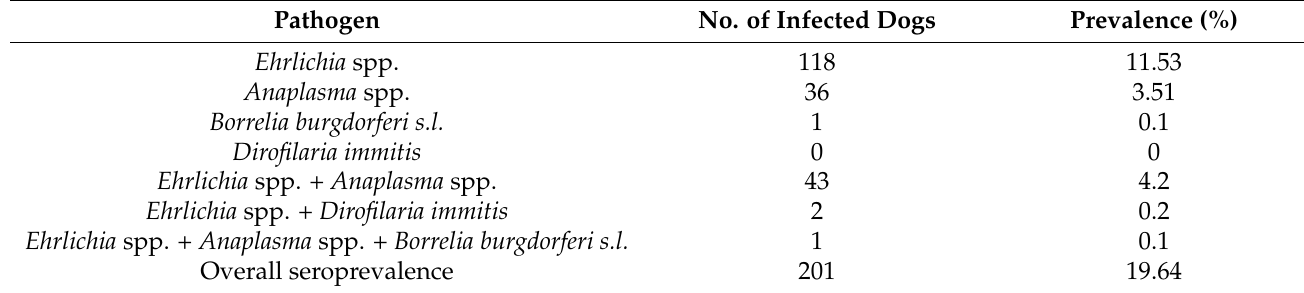
Table 1. Seroprevalence of canine vector-borne infections and co-infections in the stray dog population ( n = 1023 dogs) in the Campania Region, Italy, in